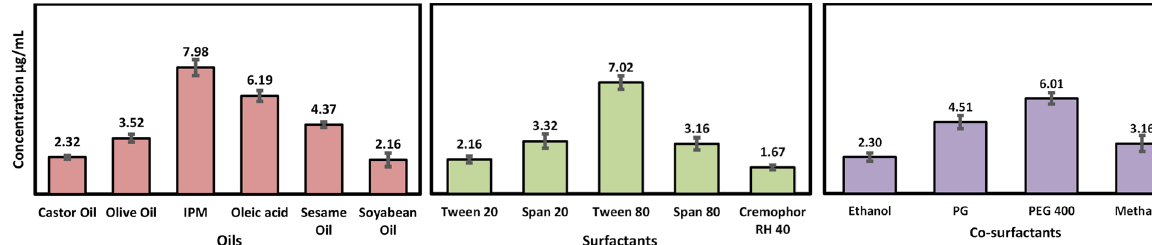
Fig. 2 Solubility of KTZ in different excipients